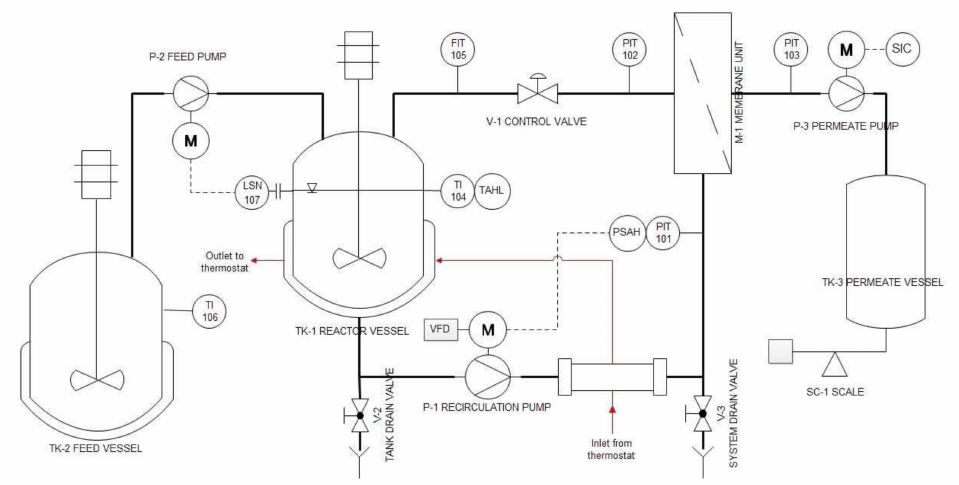
Figure 1. Piping and instrumentation diagram of continuous ultrafiltration-assisted enzymatic reactor